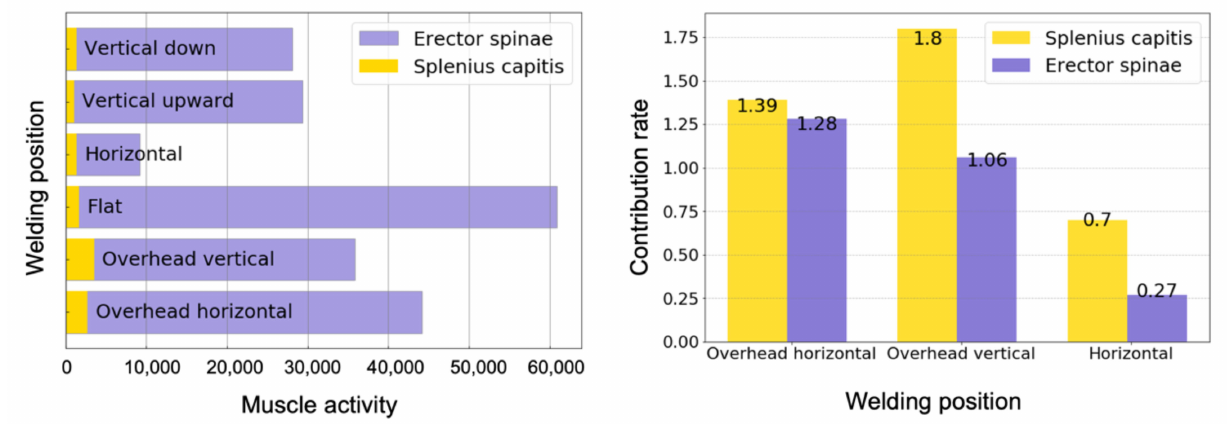
Figure 10. Amount of muscle activity (left) and posture contribution rate (right) of the ES and